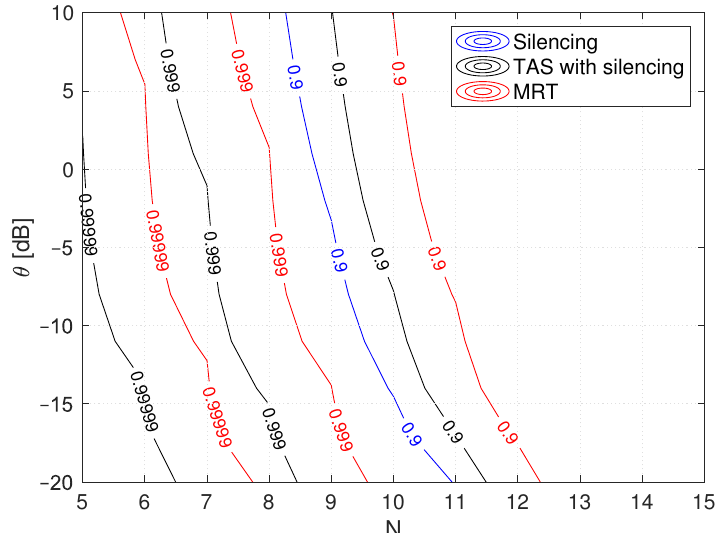
Figure 5. Illustration of reliability analysis for silencing, TAS with silencing and MRT schemes with respect to threshold θ as a function of N with fixed k = 3 cooperating RRHs.